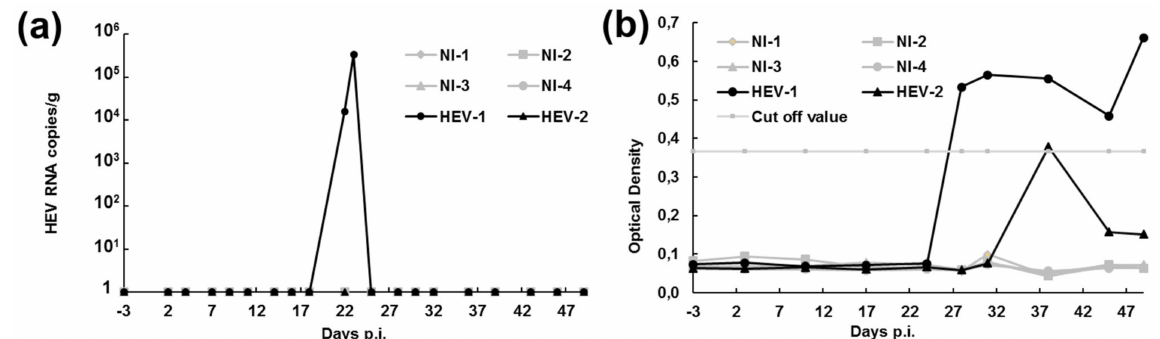
Figure 4. Experimental infection of two pigs with HEV harvested after six passages on HepaRG. ( a ) Kinetics of HEV excretion in the faeces quantified by RT-qPCR and expressed in number of HEV RNA copies/g of faeces. ( b ) Kinetics of HEV seroconversion. The presence of anti-HEV antibodies in serum was analysed by ELISA. NI = non-infected; p.i. =